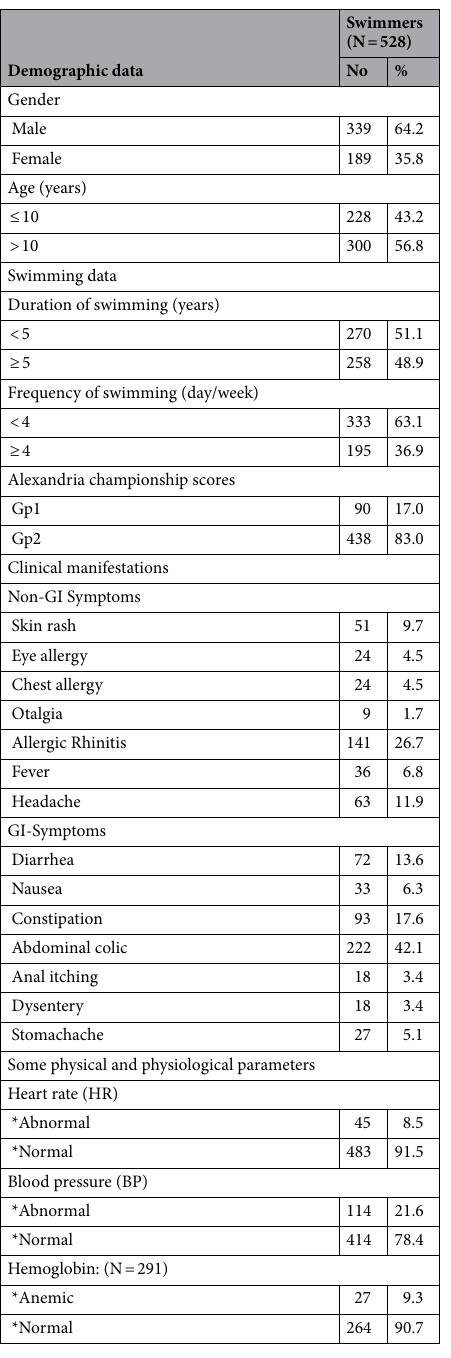
Table 3. Distribution of young swimmers according to some demographic and swimming data, some clinical manifestation, and some physiological and hematological parameters. Gp group. Gp1: Swimmers who achieved the best records. Gp2: Swimmers who achieved low records and under training. Abnormal HR: HR below or above the normal range of target HR for vigorous-intensity physical activity. The Abnormal BP: below the minimum or above the maximum BP of age